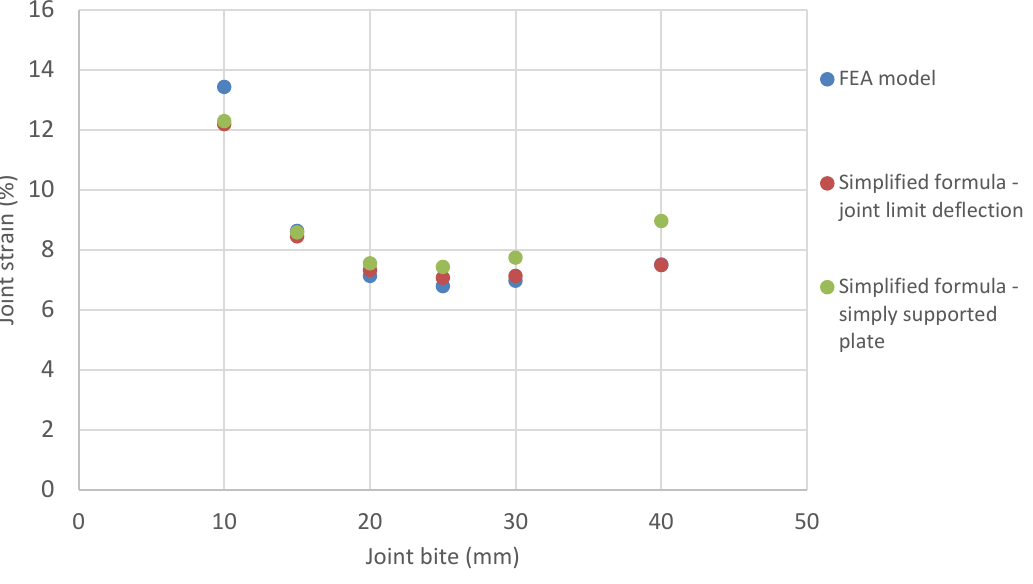
Fig. 10: comparison of maximum value of joint strain as a function of sealant bite for 3D FEA and simplified